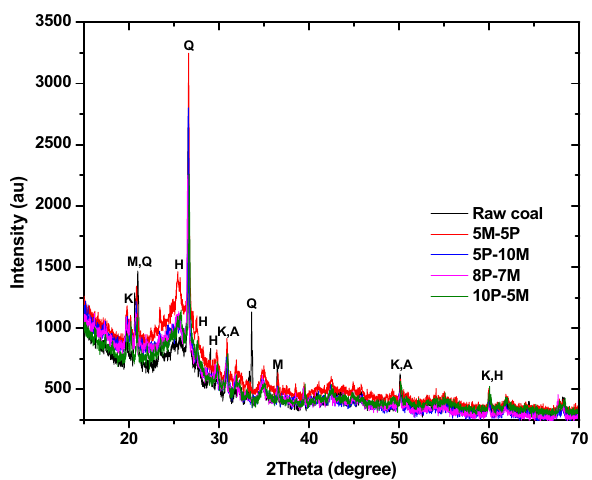
Figure 3. Diffractograms of bio-coal briquette produced from 90:10 hybrid